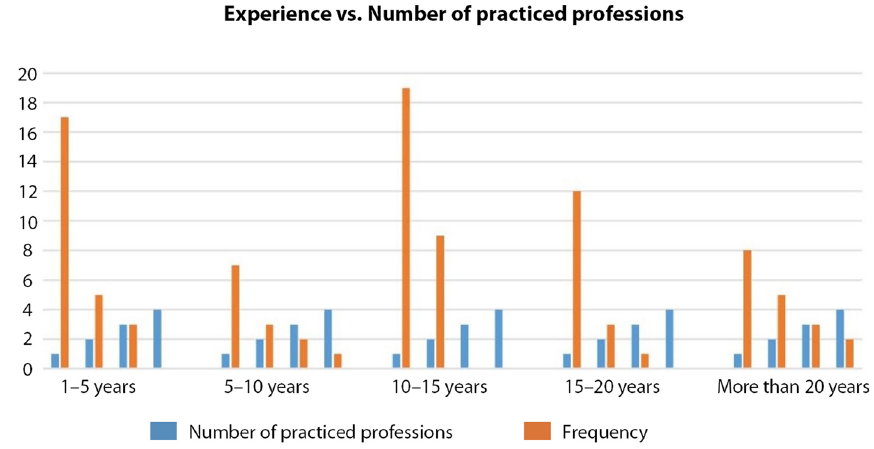
Fig. 10 Experience vs. number of practiced professions (Source: the authors)